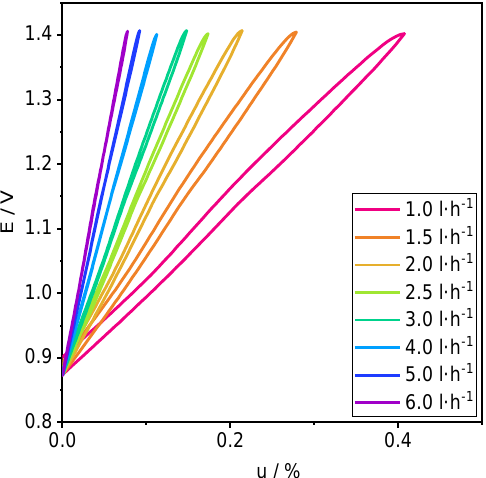
Figure 4. Operating potential dependent on the fuel utilization, calculated according to Faraday, for various flow rates for a composition of 80% CO 2 + 20% CO at 800 °C.